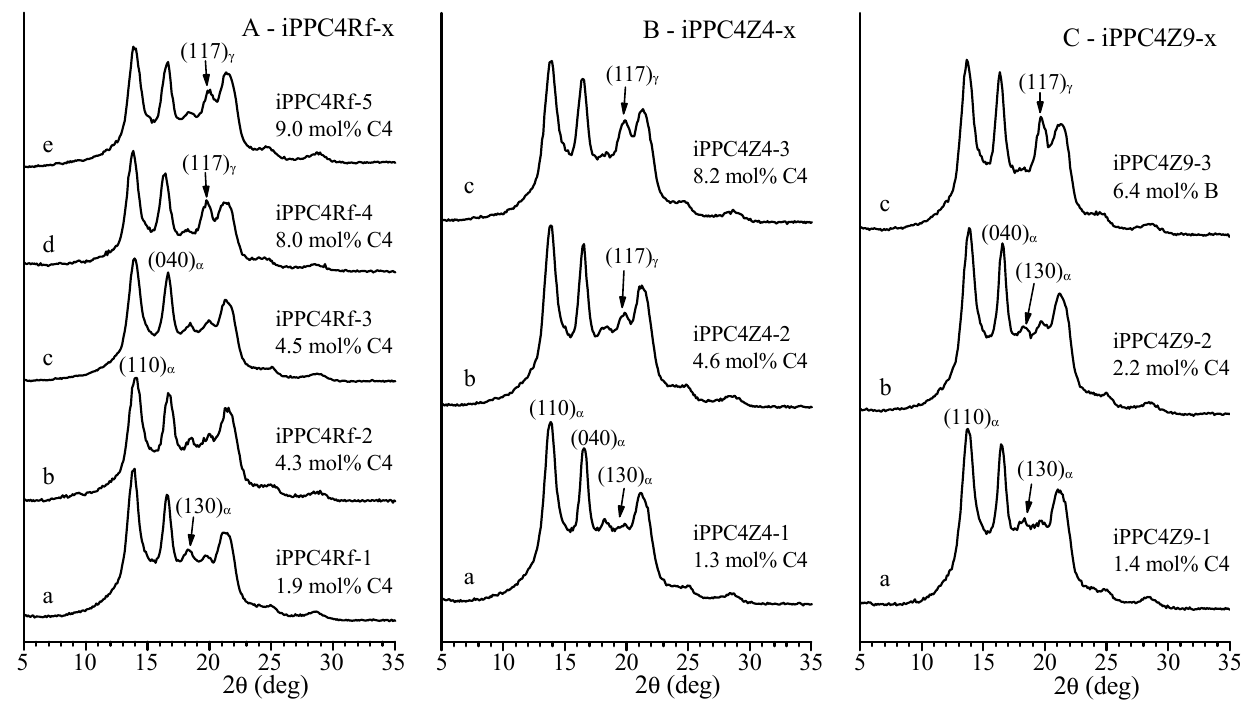
Figure 1. X-ray powder diffraction profiles of as-prepared samples of iPPC4 copolymers of the indicated butene concentration. Isotactic samples iPPC4Rf-x with [ rr ] < 0.1 mol% ( A ) and less isotactic samples iPPC4Z4-x with [ rr ] = 2.0–2.4 mol% ( B ) and iPPC4Z9-x with [ rr ] = 2.5–3.4 mol% ( C ).